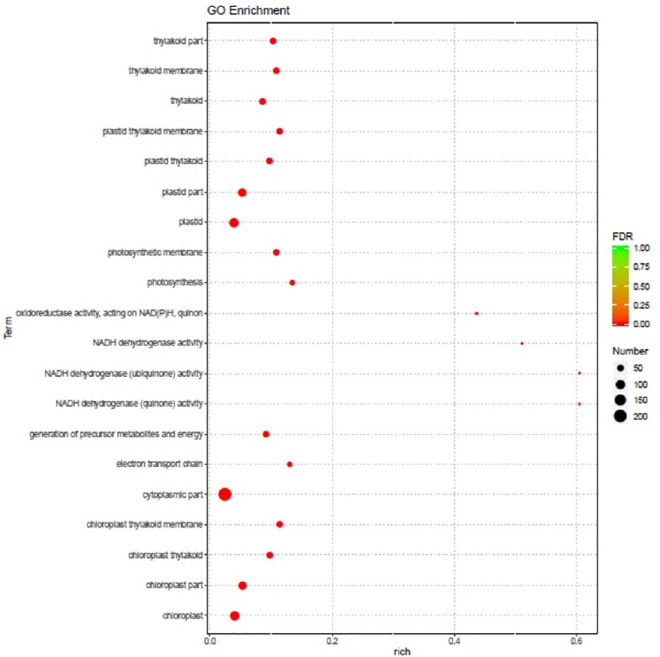
Fig 5. Gene Ontology (GO) enrichment analysis of the differentially expressed genes during the interaction between B . aryabhattai and Arabidopsis. The rich factor, false discovery rate (FDR) values, and the number of genes with the associated GO term were used to determine the level of enrichment based on the GO enrichment analysis results. The number of distinct genes with the appropriate GO term to the number of annotated genes is referred to as the rich factor. The number of enriched genes is shown by the size of each dot. Each dot is colored differently: red dots represent pathways with high concentration, whereas green dots suggest pathways with low